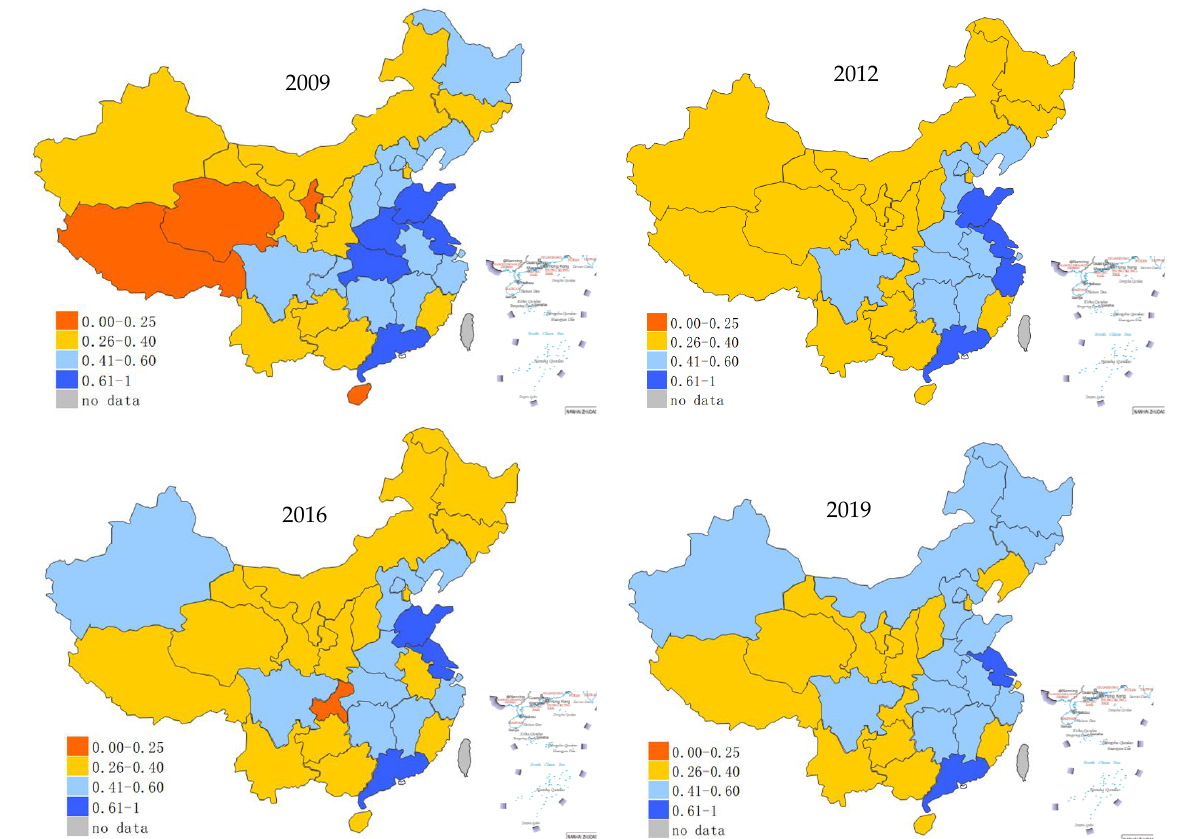
Figure 1. The development level of the aging industry. From a spatial perspective, China’s aging industry has large regional differences. During 2009-2019, the higher level of aging industry were in developed provinces and cities in the central and eastern regions (Figure 1). The value of Guangdong Province, ranked first in 2009 with 0.7778, was 3.8 times that of Hainan Province with the smallest value of 0.2074. In 2019, the value of Guangdong Province, ranked first with 0.7812, was 2.8 times that of Gansu Province with the smallest value of 0.2824. The tendency indicates that the regional differences in the development of the aging industry became narrow, and the development of the aging industry in less developed areas accelerated. From the perspective of sub-regions, as shown in Figure 2, the development of the aging industry in the eastern and central regions is above the national average. There is indication that the overall development trend of the aging industry in the western region gradually improved, the eastern region has a slight decline, and the central and the north- east improved from 2017 after experiencing a large decline.